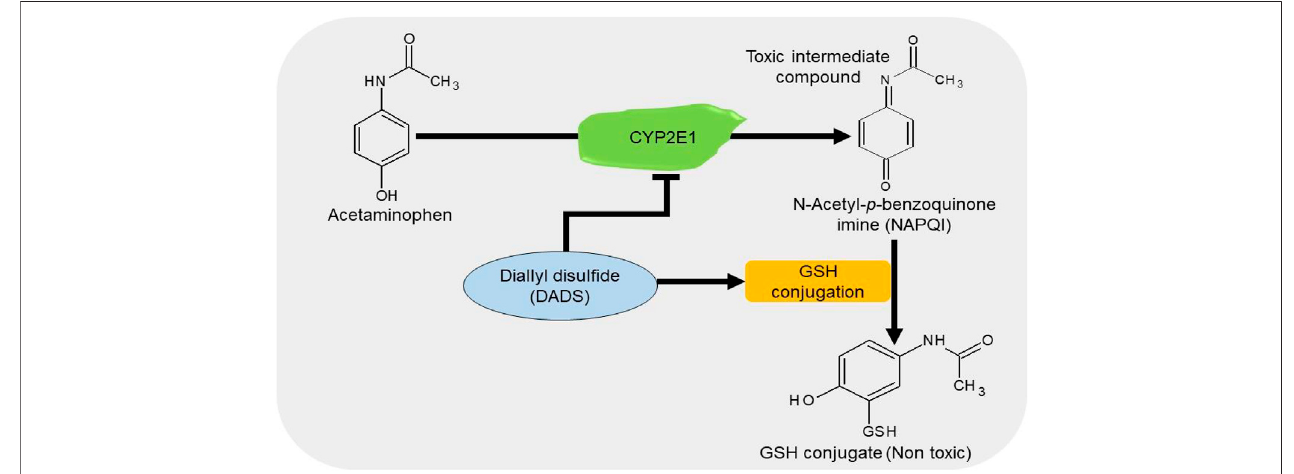
FIGURE 6 | The diagrammatic presentation of the inhibitory effect of H 2 S donors on cytochrome p450 2E1 (CYP2E1). H 2 S donors increase the GSH levels and suppress the expression of CYP2E1, an enzyme responsible for the metabolism of APAP. By reducing the enzyme, H 2 S donors prevent the formation of a toxic intermediate metabolite NAPQI and by increasing GSH level, it facilitates the conjugation of NAPQI to form a nontoxic metabolite. H 2 S, hydrogen sul fi de; CYP2E1, cytochrome p450 2E1; GSH, glutathione; APAP, acetaminophen; NAPQI, N-acetyl-p-benzoquinone imine.